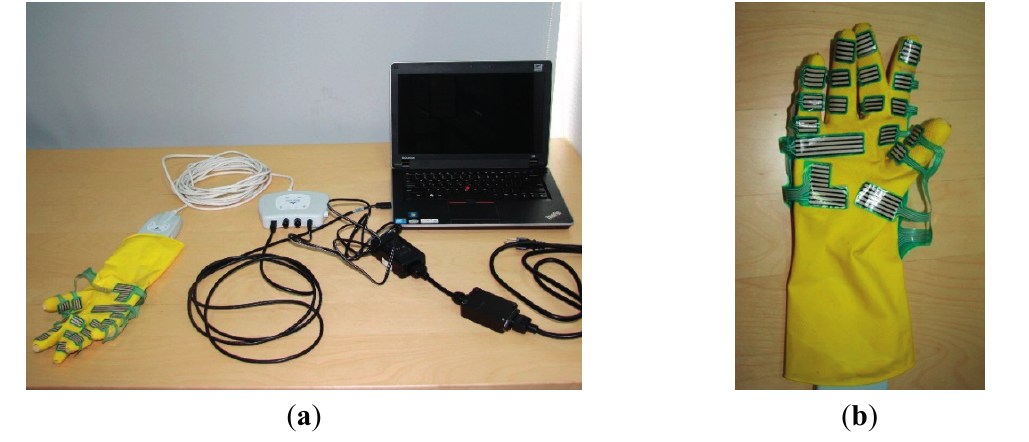
Figure 5. ( a ) Tekscan grip pressure mapping system; ( b ) Sensor mounted on a right hand rubber glove.